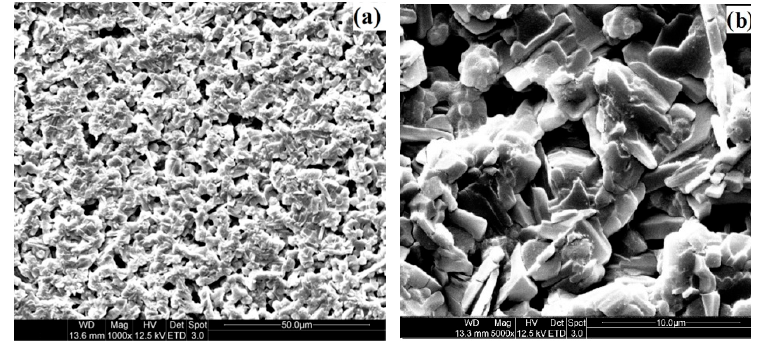
Figure 1. Morphological observation of chitosan coating (1.0%) by SEM: ( a ) 1000×; and ( b ) 5000×.